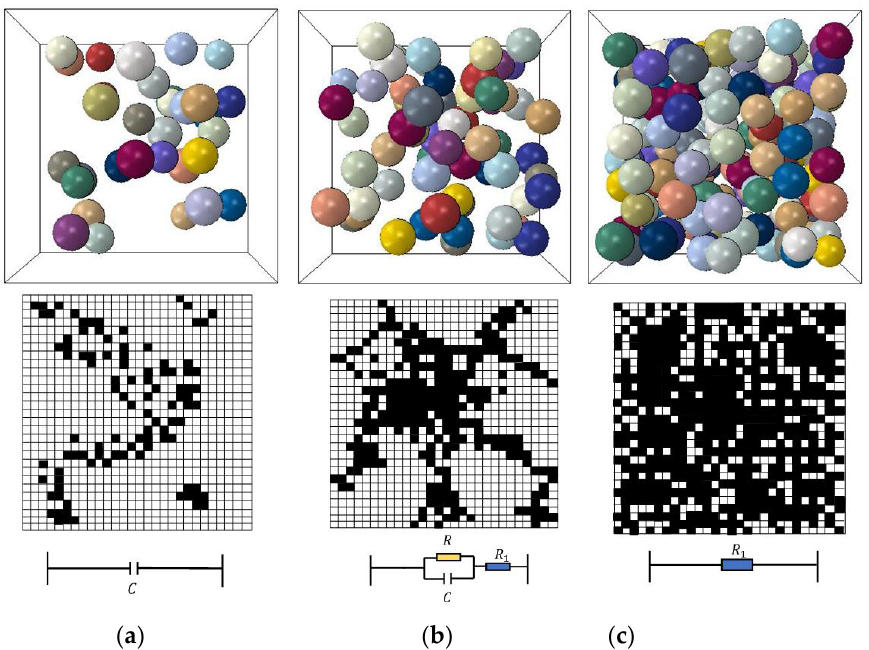
Figure 4. Relationship between the filler amount and the conductivity ( R and C represent the resistance and capacitance between two adjacent aggregates, respectively, and R 1 is the resistance across the aggregates): ( a ) Insulation region; ( b ) Percolation region; ( c ) Conductive region.